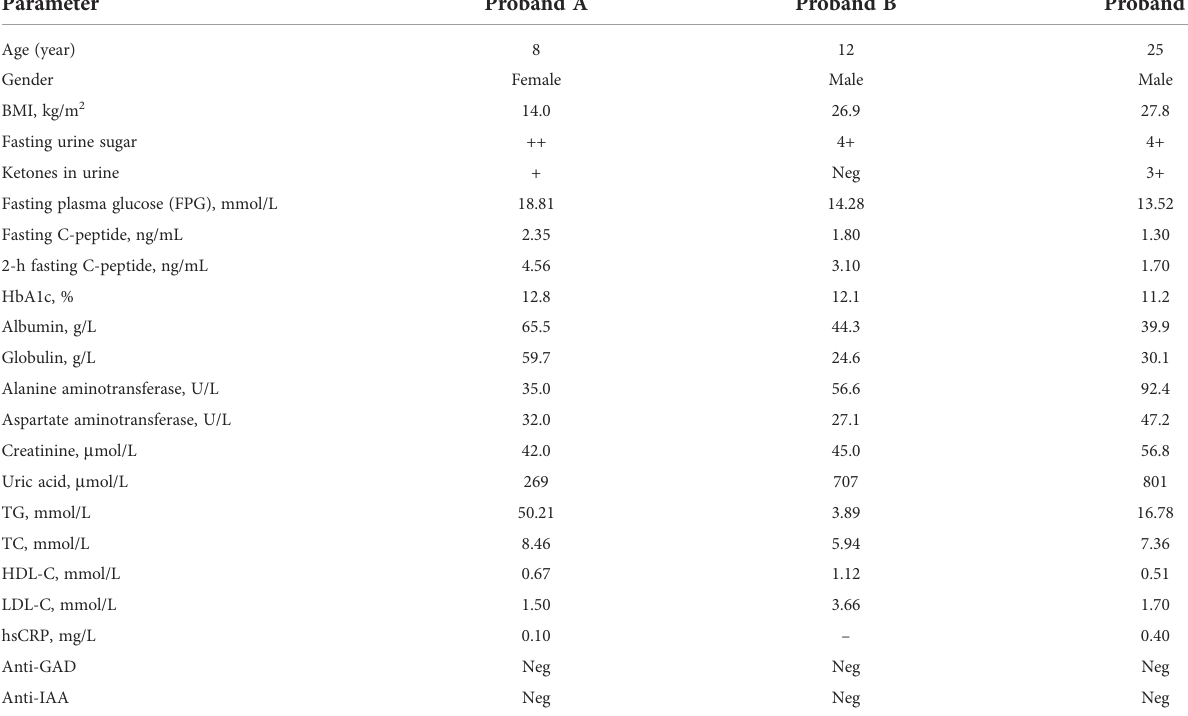
TABLE 1 Physical and laboratory